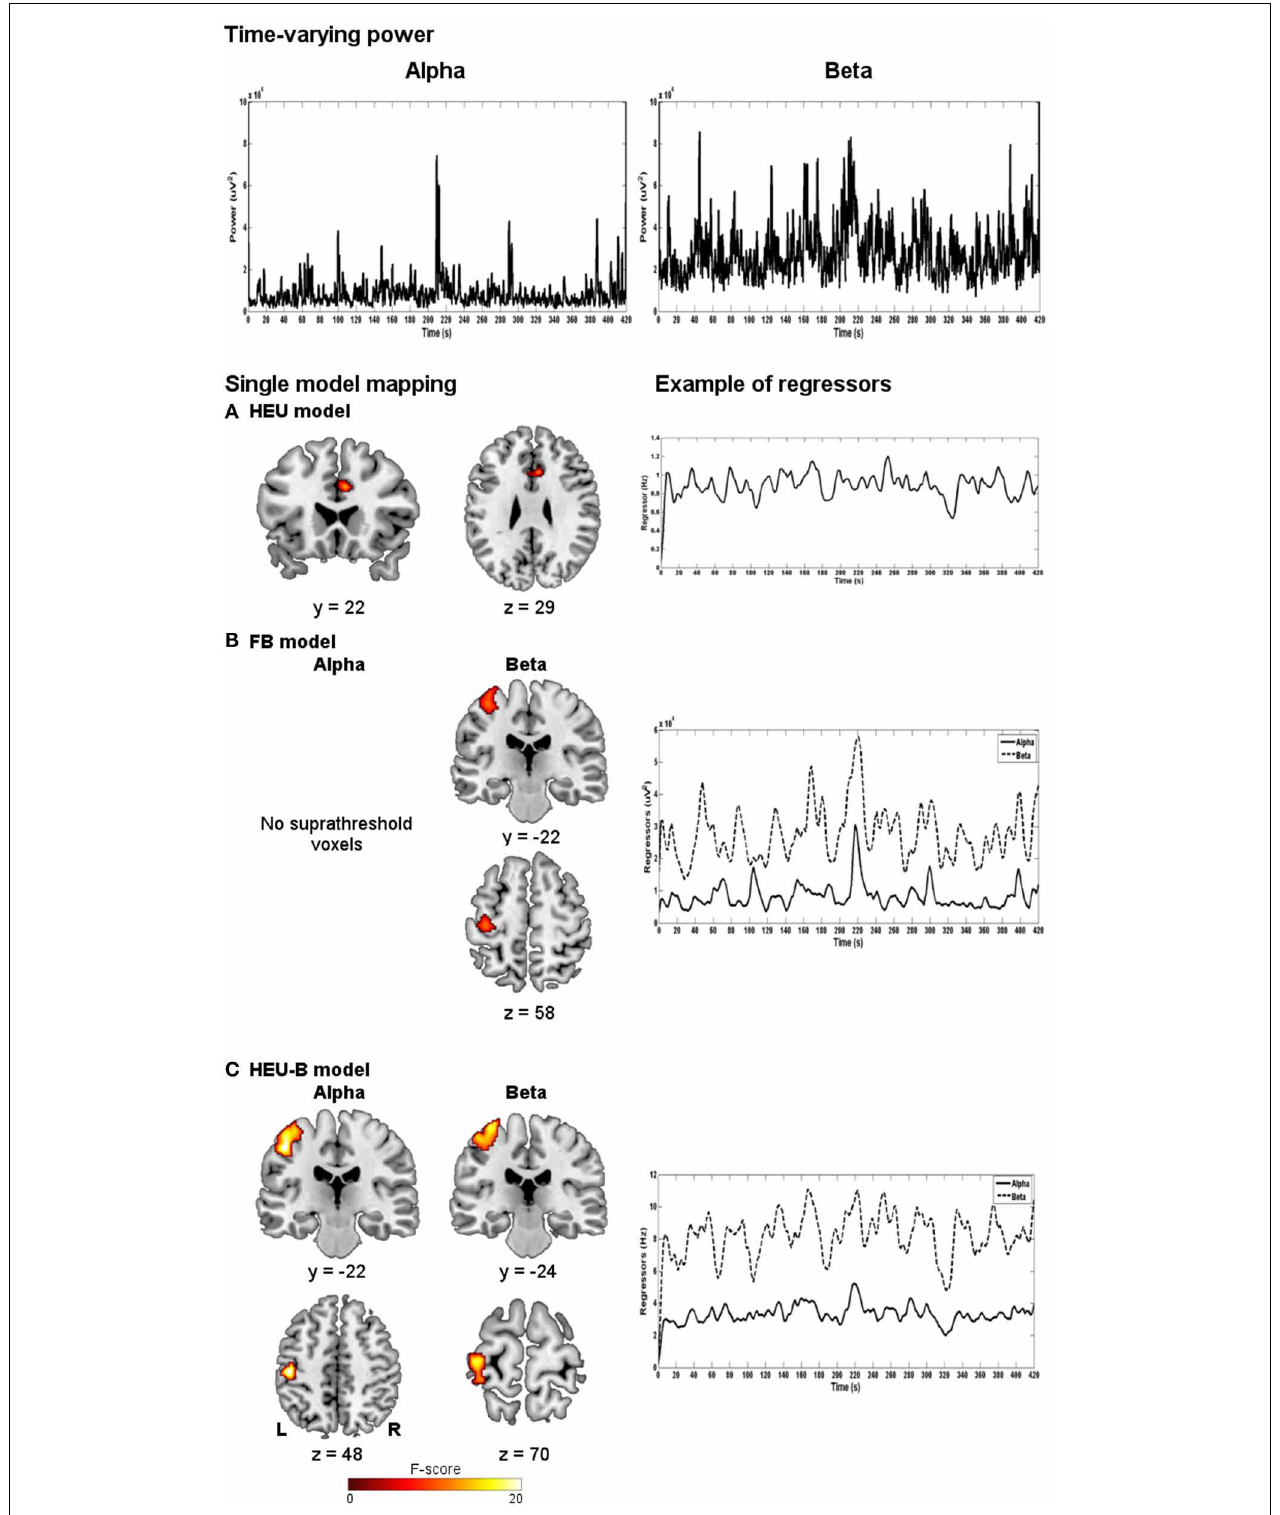
FIGURE 3 | Single-model mapping. Top panel: alpha and beta time-varying EEG power for a representative subject. Bottom panel: group maps obtained using HEU (A) , FB (B) and HEU-B (C) models, along with examples of regressors for a representative